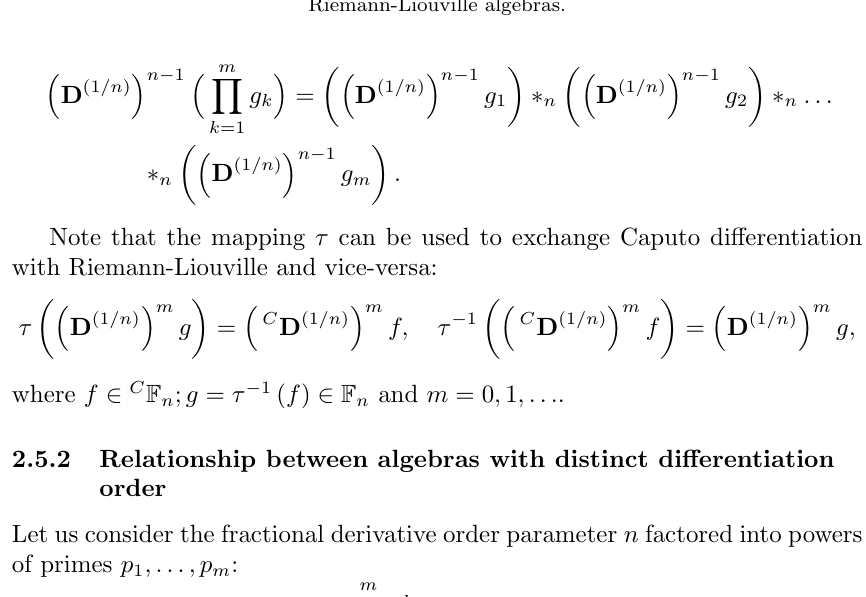
Figure 1. Schematic diagram of the bijective mappings between Caputo and Riemann-Liouville